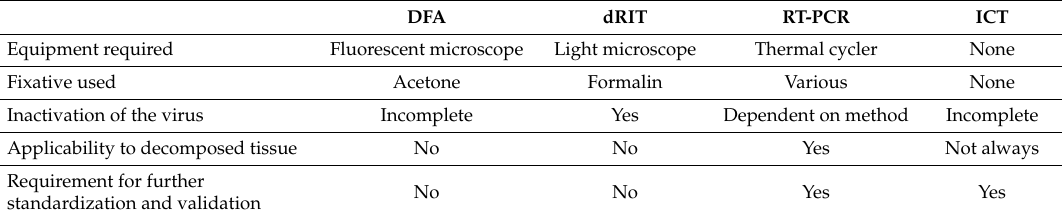
Table 3. Comparison of DFA, dRIT, RT-PCR and the immunochromatrographic test (ICT) for the laboratory diagnosis of